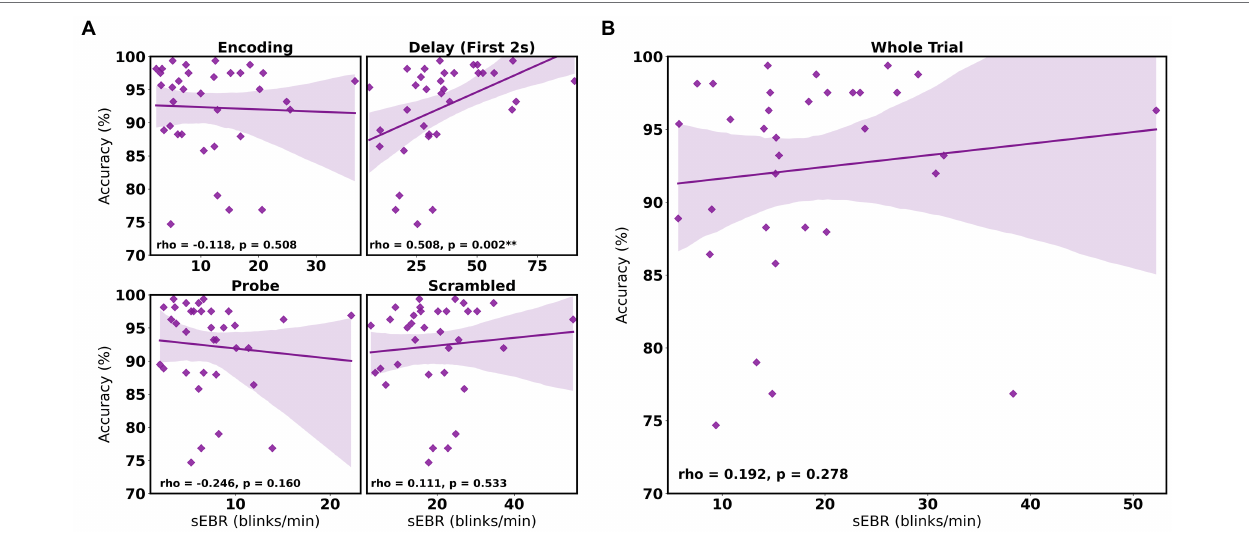
FIGURE 5 | Correlation between sEBR during different phases of the task and task accuracy in Experiment 2. Correlation plots show sEBR on the x-axis and task accuracy on the y-axis. (A) These four plots are encoding (top left), the first 2 s of the delay (top right), probe (bottom left), and scrambled (bottom right) periods. The delay period shows a strong positive correlation ( p = 0.002, significant after a multiple comparison correction) between task accuracy and sEBR during the first 2 s of the delay period. (B) This plot represents the relationship between sEBR during the whole trial and task accuracy. Fitted line represents linear regression model fit. Shaded region depicts 95% confidence interval. Values of p for (A) after Bonferroni correction: ** p < 0.0025.